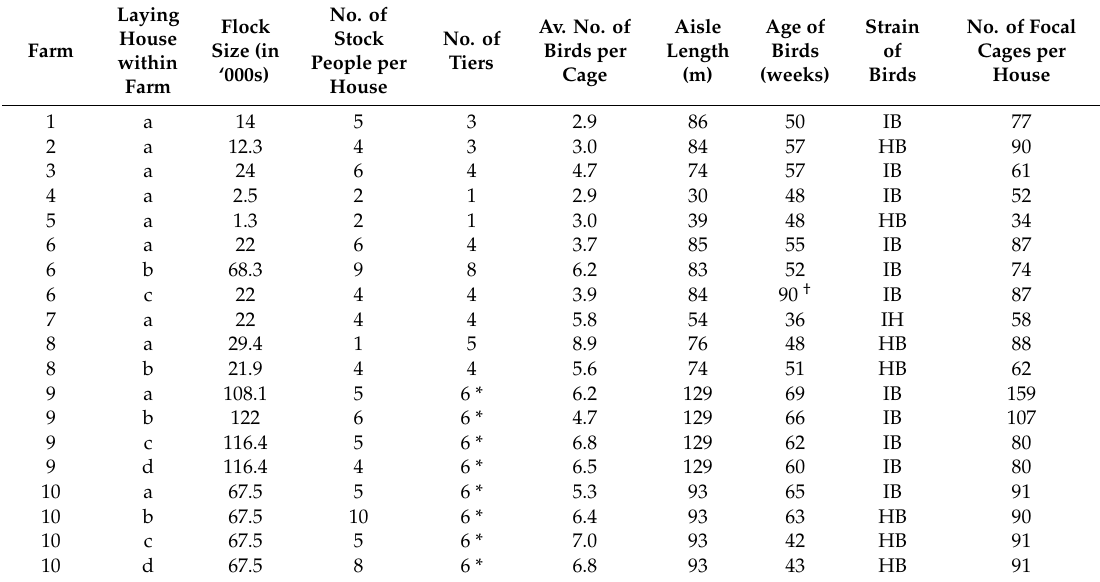
Table 1. A description of each of the laying houses used in the study, highlighting variation in design and